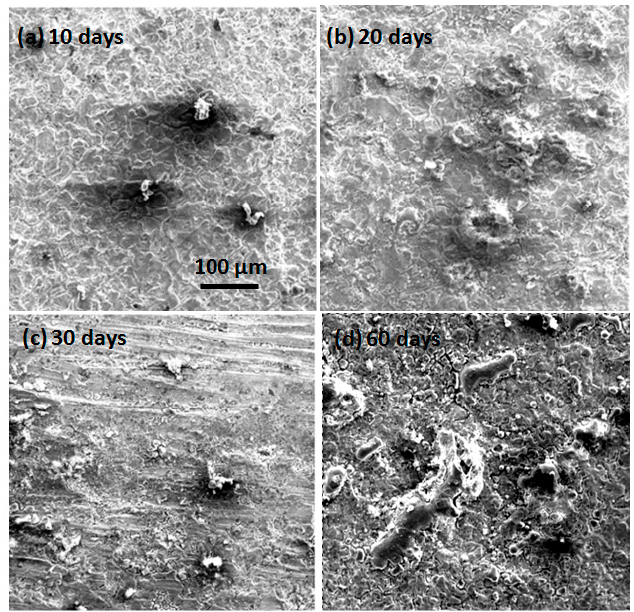
Figure 8. SEM morphologies of 316L immersed under high temperature and high pressure conditions. ( a ) after 10 days immersion; ( b ) after 20 days immersion; ( c ) after 30 days immersion; ( d ) after 60dyas immersion.